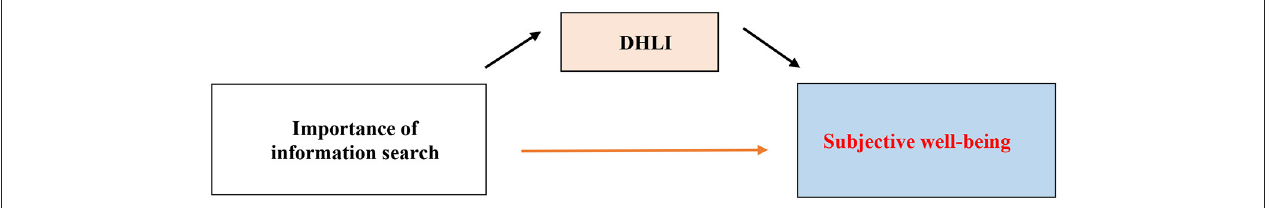
FIGURE 1 | The conceptual framework of